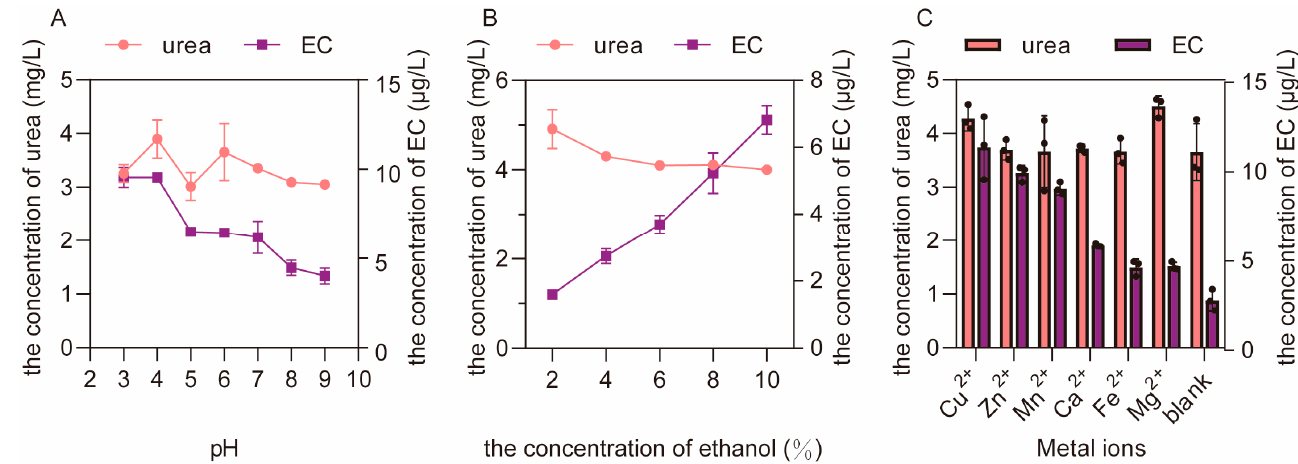
Figure 4. The effects of pH value ( A ), alcohol concentration ( B ) and metal ions ( C ) on the formation of EC and the residue of urea in aqueous reactions.